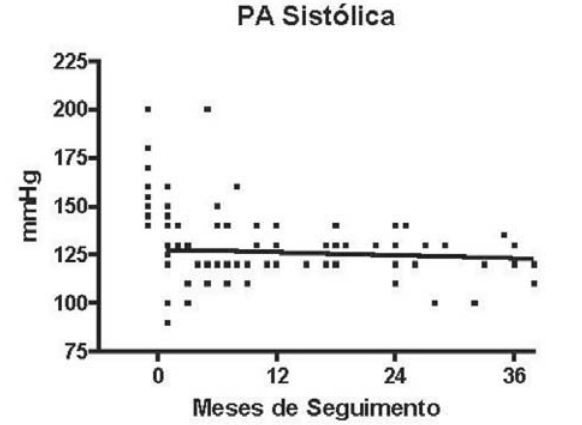
Fig. 6 - Comportamento da pressão arterial sistólica ao longo do período de seguimento. PA = pressão arterial; mmHg = milímetros de